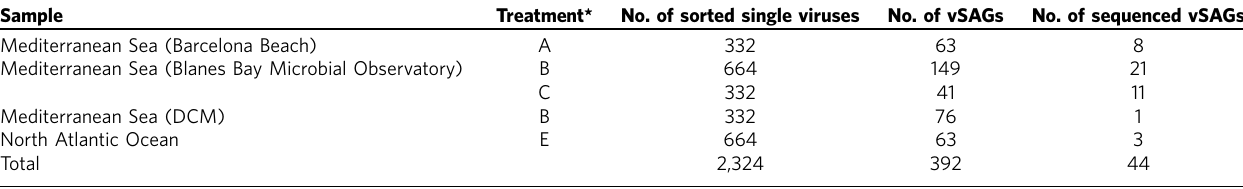
Table 1 | Summary of marine samples and viral single-amplified genomes (vSAGs). Sample